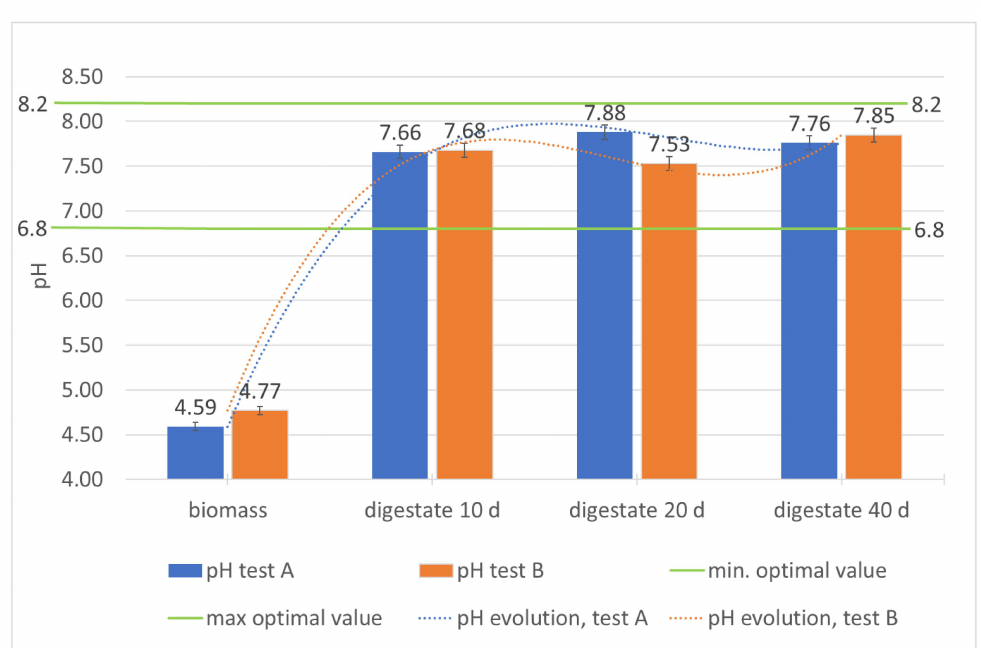
Figure 5. Monitoring of pH in the digesters during the hydraulic retention time.